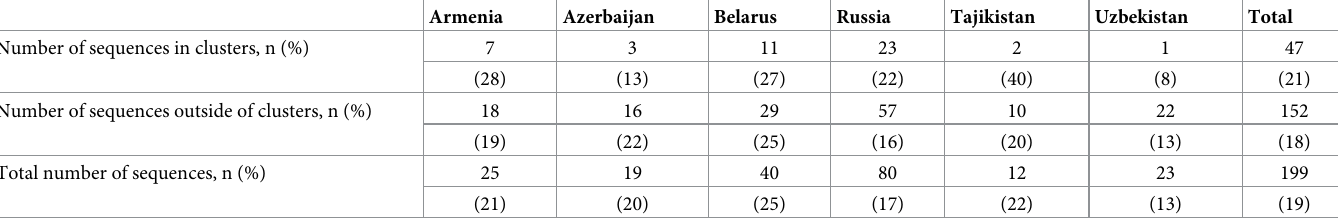
Table 6. Clustering of sequences with DRMs by